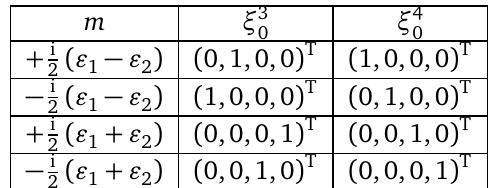
The mass parameters and additional Killing spinors that solve the con- straint eq.